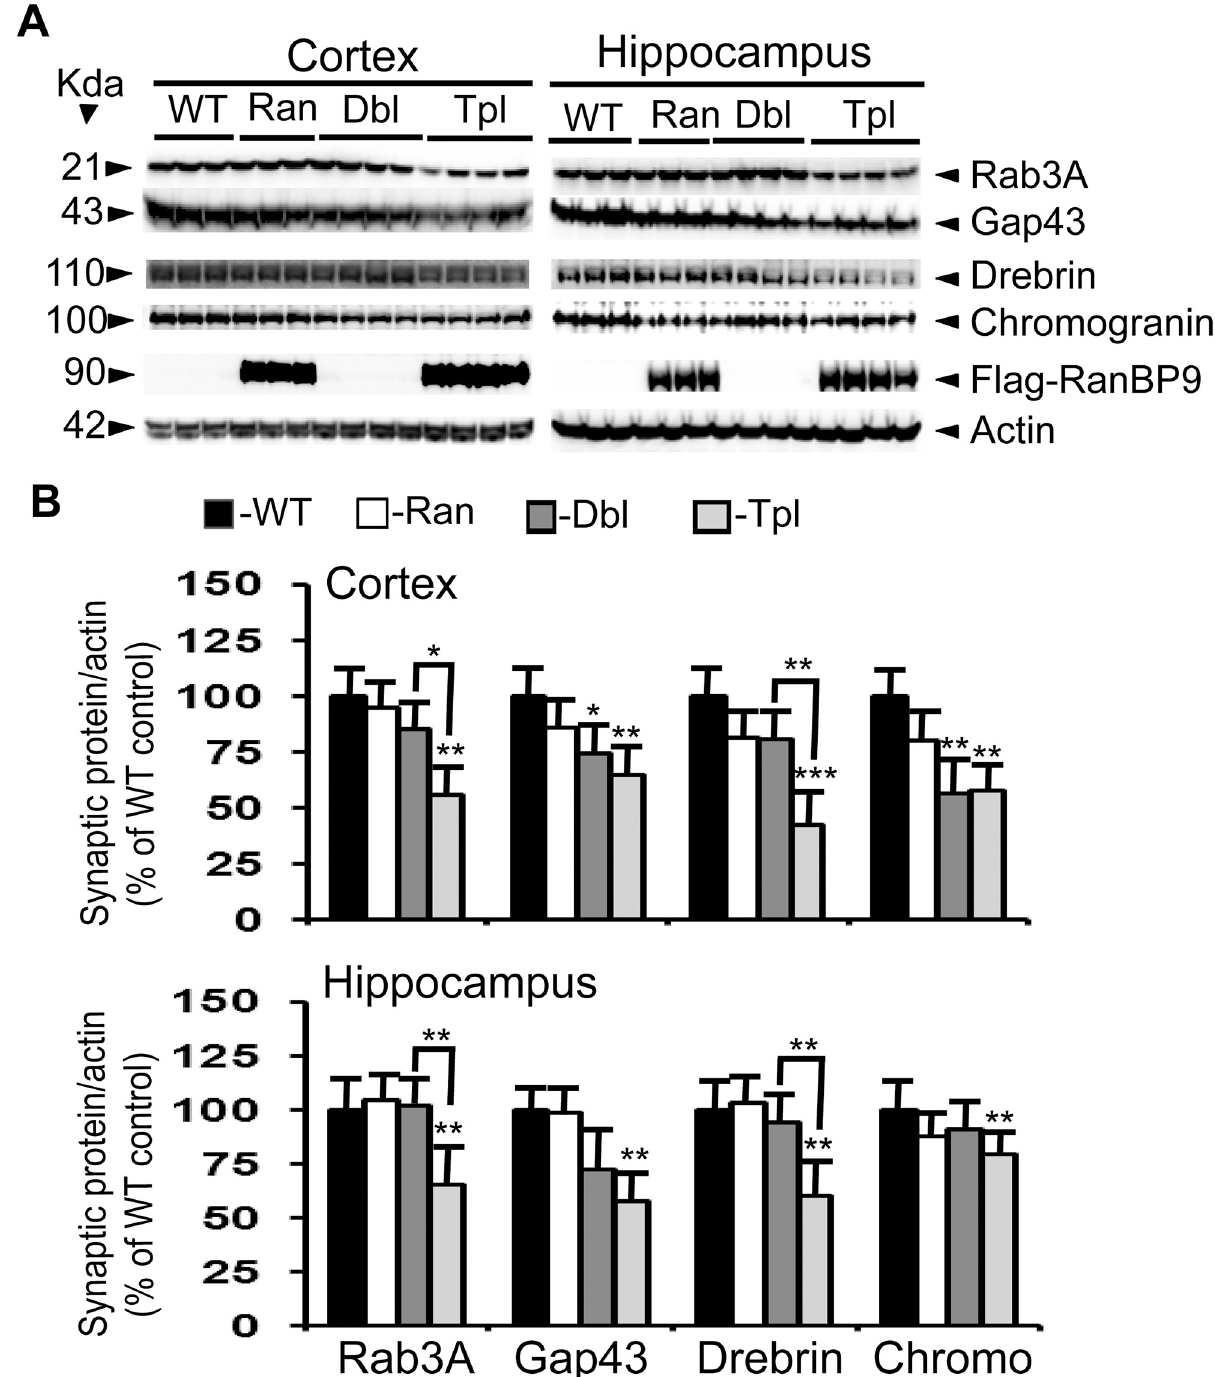
Fig 4. RanBP9 overexpression exacerbates reduction of synaptic protein levels at 6-months of age in the cortex and the hippocampus of AP Δ E9 mice. A: Brain homogenates were processed and synaptic proteins, flag-tagged RanBP9 and actin were detected as in legend to Fig 1. B: ImageJ quantitation and normalization to actin levels revealed significant differences. Rab3A levels were further reduced by 30% and 36% in the cortex and hippocampus respectively in the triple transgenic mice compared to double transgenic mice. Similarly, drebrin levels were further reduced by 38% and 33% in the cortex and the hippocampus in the triple transgenic mice compared to double transgenic mice. Gap43 levels were reduced in the cortex by 36% in the triple transgenic mice and by 26% in the double transgenic mice compared to WT controls. In the hippocampus gap43 levels were reduced only in the triple transgenic mice by 43%. In the cortex, chromogranin levels were reduced by 44% in the double and by 44% in the triple transgenic mice, whereas in the hippocampus a 21% reduction was observed only in the triple transgenic mice. ANOVA followed by post-hoc Tukey’s test revealed significant differences. � , p < 0.05, �� , p < 0.01, ��� , p < 0.001 in AP Δ E9/RanBP9 or AP Δ E9 mice compared to WT mice as indicated in the figure. The data are mean ± SEM, n = 3 for WT and RanBP9 mice, and n = 4 for AP Δ E9 and AP Δ E9/RanBP9